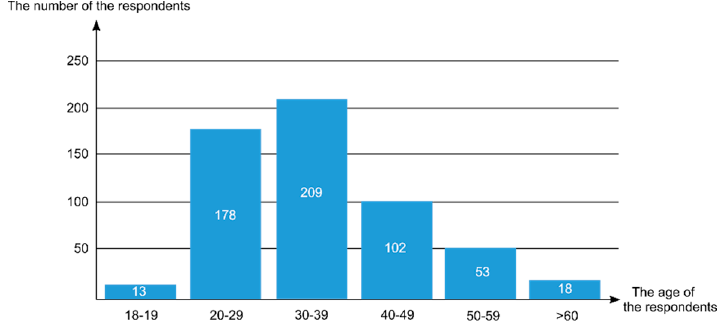
Figure 10. The age structure of the respondents (own elaboration).